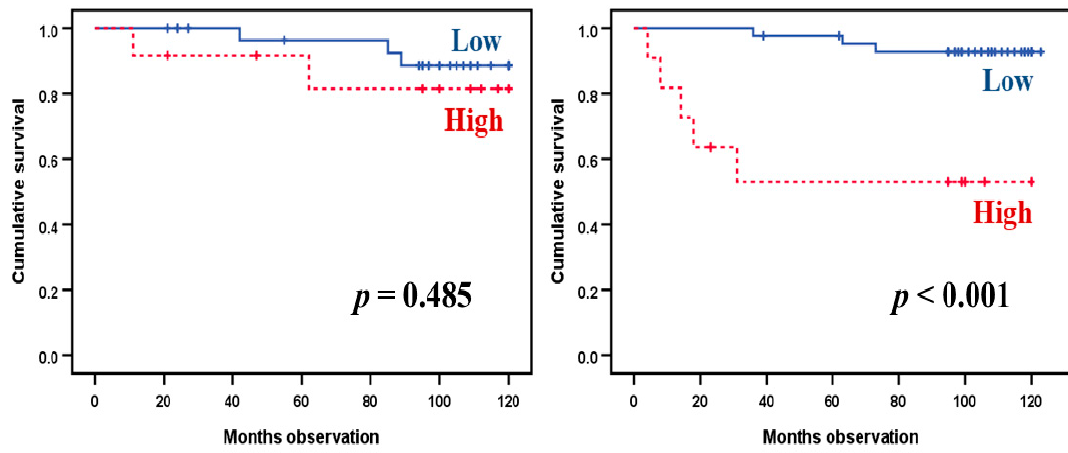
Figure 3. Comparison of kidney cancer-related death for the patient subsets identified in the hierarchical clustering analysis based on IL6 family mediators. As indicated in Figure 2, the 97 patients could be sub-classified into the two main subsets referred to as (left) IL6 high CNTF high and (right) IL6 low CNTF low subsets. The patients were classified into quartiles based on their IL33R α serum levels, and we compared the survival of patients classified in the highest versus the three lowest IL33R α quartiles. The IL6 high CNTF high (left) and IL6 low CNT low patients (right) were analyzed separately. The p -values are indicated in the figure